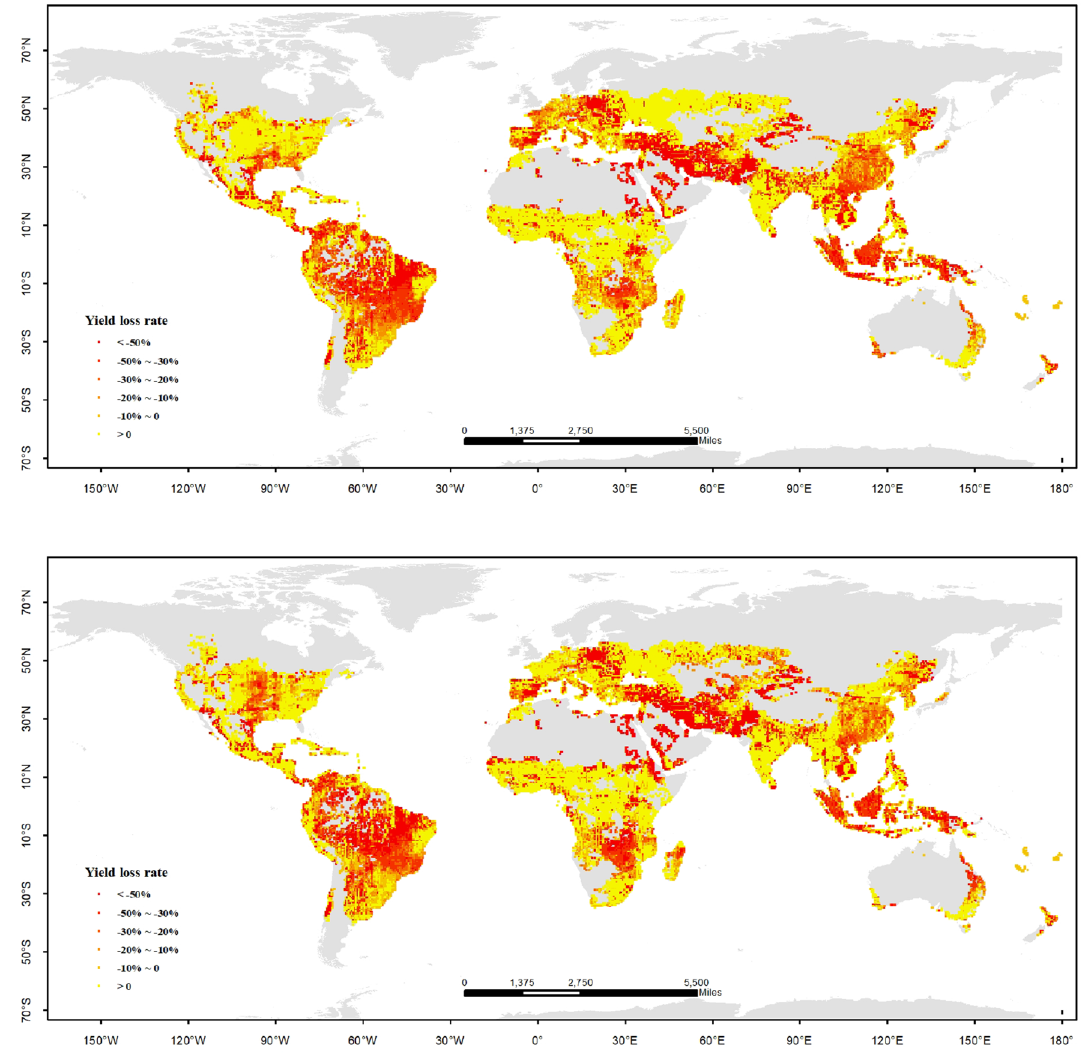
Figure 3. Distribution of yield loss rate on maize in the world under global warming by 1.5 °C (up: IPSL- CM5A-LR model, RCP 2.6; down: GFDL-ESM2M model, RCP 4.5). The figure has been generated using ArcGIS 10.2 and Natural Earth-Free vector and raster map data @ https:// natur alear thdata.